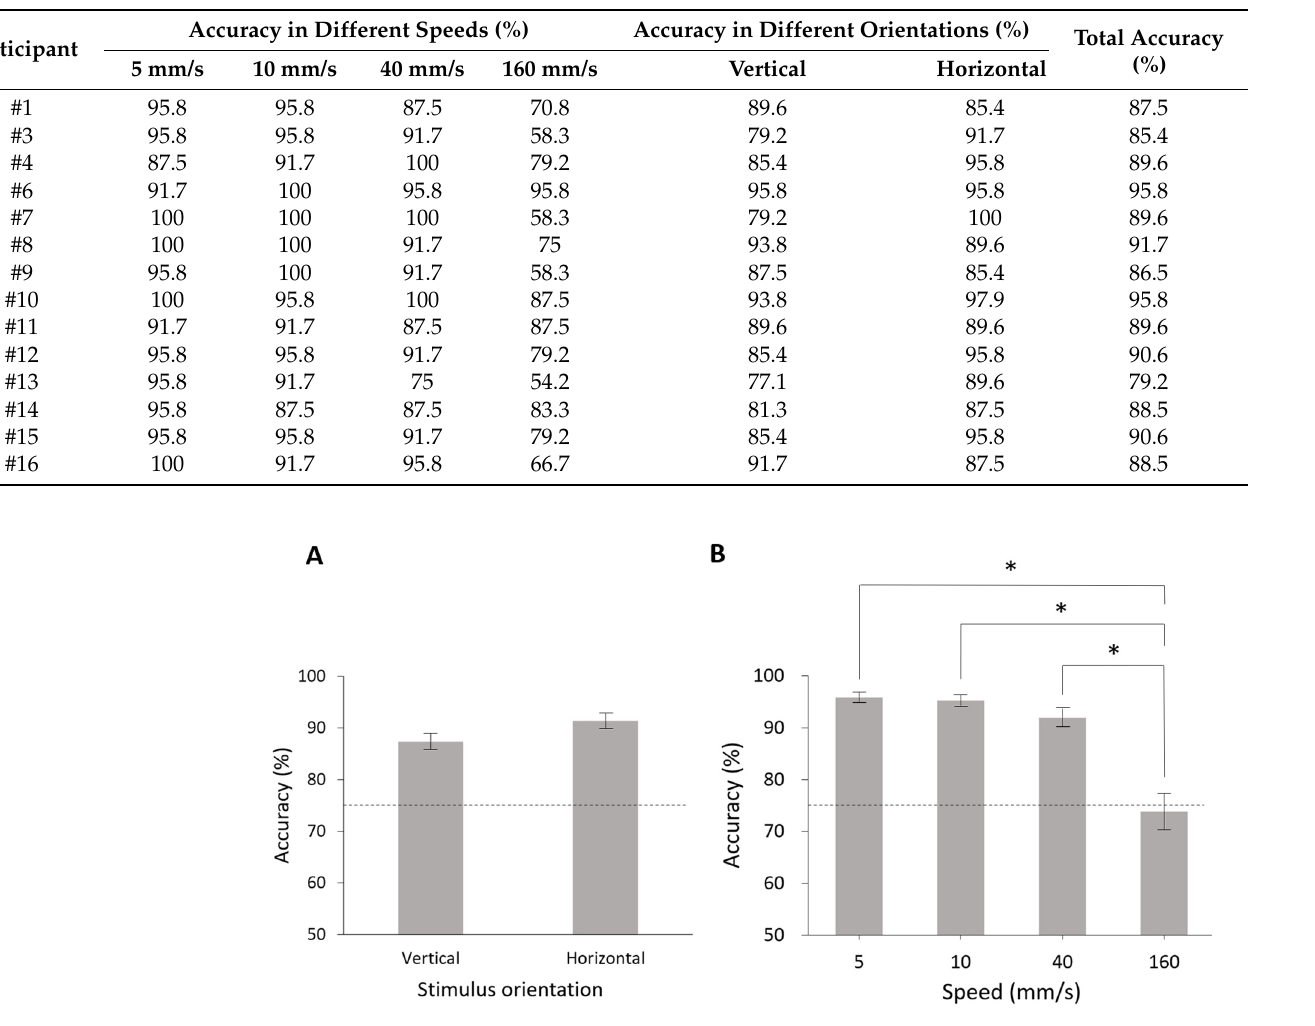
Figure 4. Performance results of 1, 2, and 4 mm sine ‐ wave grating ball in terms of accuracy of ori ‐ entation identification in different stimulus orientations and speeds. ( A ) Comparison of the accuracy of 1, 2, and 4 mm sine ‐ wave grating ball stimulation revealed a significant difference ( p = 0.019). The accuracy of 1, 2, and 4 mm sine ‐ wave grating ball stimulation is 77.67 ± 5.14%, 89.88 ± 1.99%, and 95.93 ± 1.45%, respectively. The error bars indicate SEM. ( B ) Comparison of the accuracy for speeds of 5, 10, 40, and 160 mm/s of 1, 2, and 4 mm sine ‐ wave grating ball stimulation revealed that tactile accuracy differed across 5 mm/s and 160 mm/s ( p < 0.001, repeated measure ANOVA test). The ac ‐ curacy for speeds of 5, 10, 40, and 160 mm/s are 96.87 ± 4.02%, 97.57 ± 3.30%, 94.79 ± 5.06%, and 73.26 ± 12.24%, respectively, * indicates p < 0.05 in post hoc comparisons. 4. Discussion MTS is a robotic tactile stimulator that could be applied for tactile function capability assessments [17,18,23]; it is novel because a standard and feasible method has yet to be established. In the present study, we developed an MTS ‐ based program for tactile acuity evaluation. The results demonstrated the following: (1) the examining process could be easily performed by examiners, and all of the participants passed both training sessions with accuracy above the predefined threshold, a finding that supports the utility of the